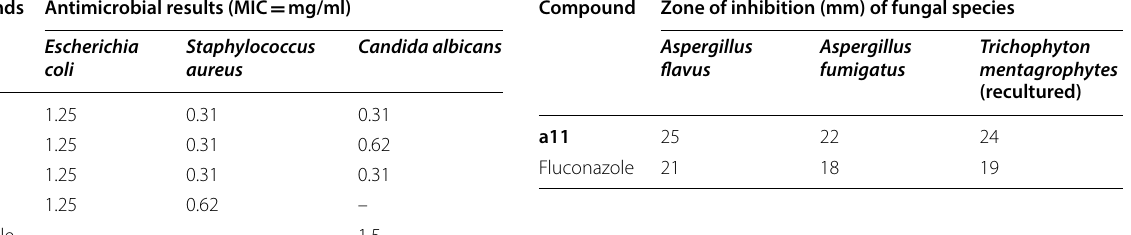
Table 4 The MIC (mg/ml) value of the compounds a7, a8 and a9 tested against organisms Compounds Antimicrobial results (MIC